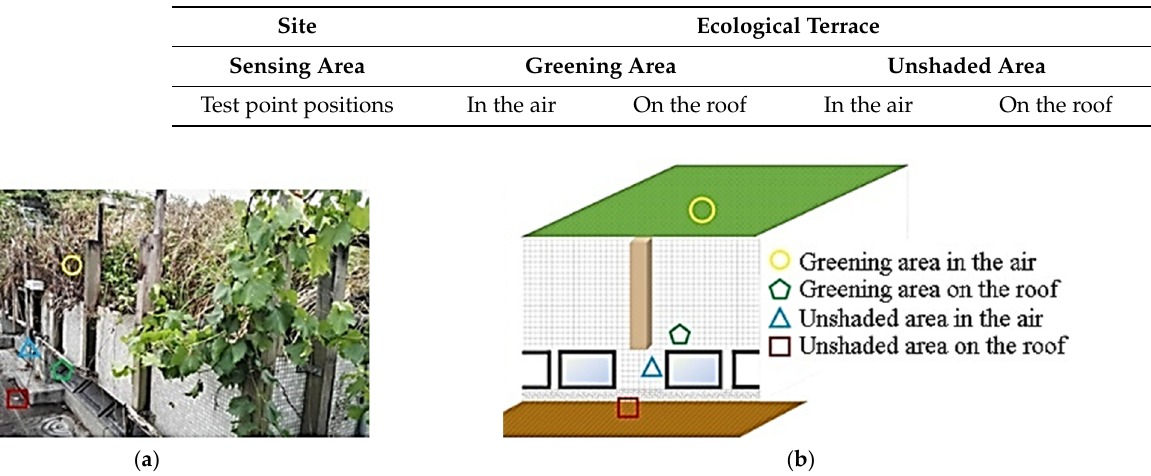
Table 2. Sensing positions on the ecological terrace.